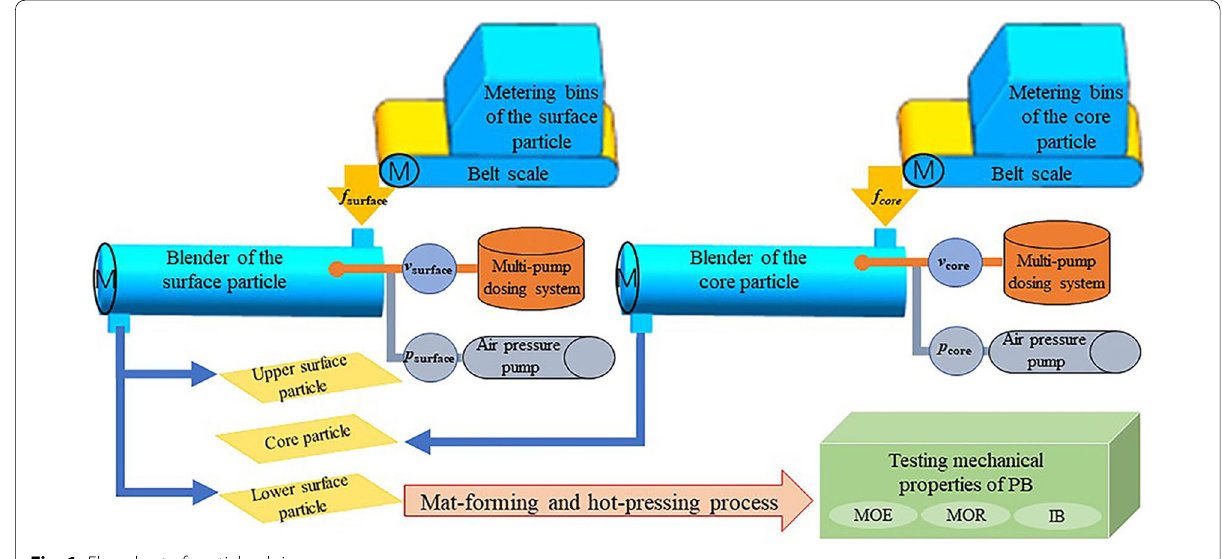
Fig. 1 Flowchart of particle